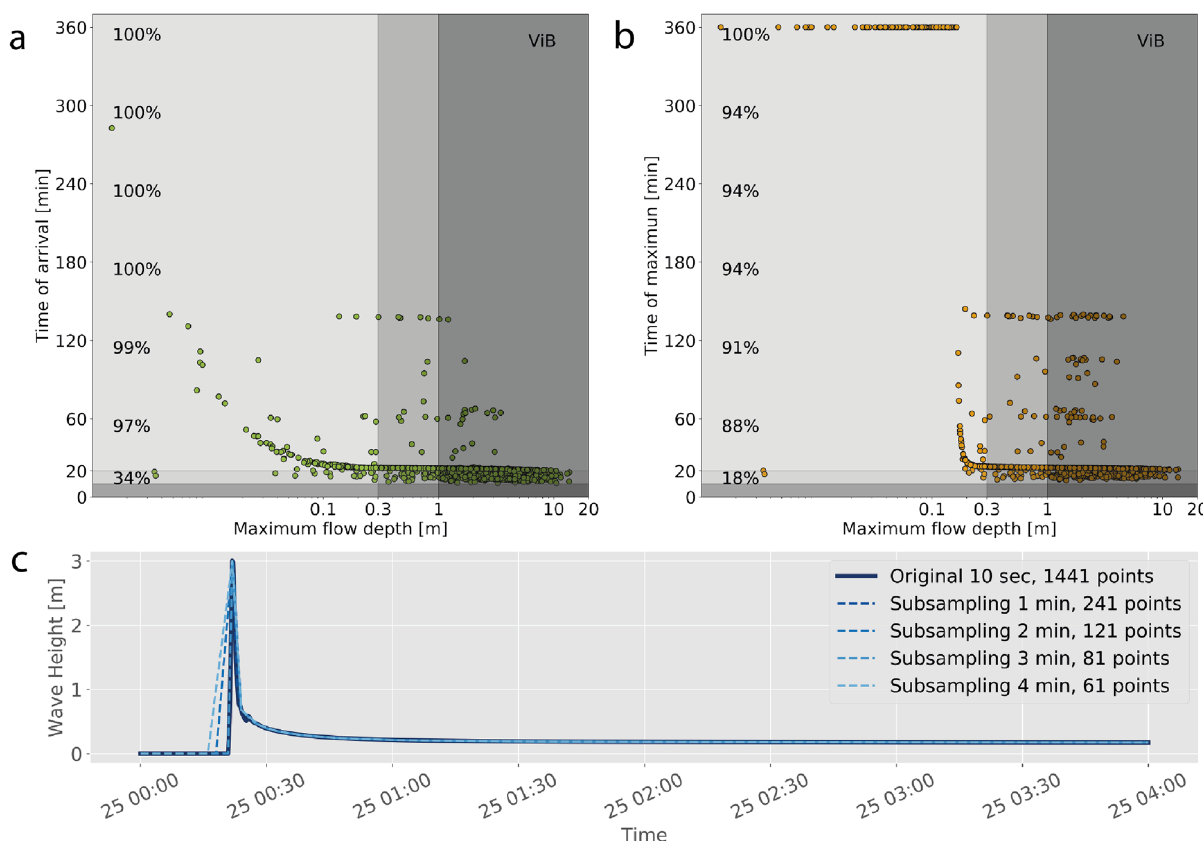
Figure 2. Scatter plots of the joint distribution of ( a ) maximum flow depth and tsunami arrival time; ( b ) maximum flow depth and time of the maximum, for all scenarios (dots). Vertical colored regions distinguish between the tsunami amplitude values used to categorize the hazard 21 . Horizontal coloring distinguish between very fast, fast and late arrivals, following 68 . Percentage values on the left indicate the cumulative fraction of events as a function of time. ( c ) Sample time series of inundation, showing the effect of different sub-sampling